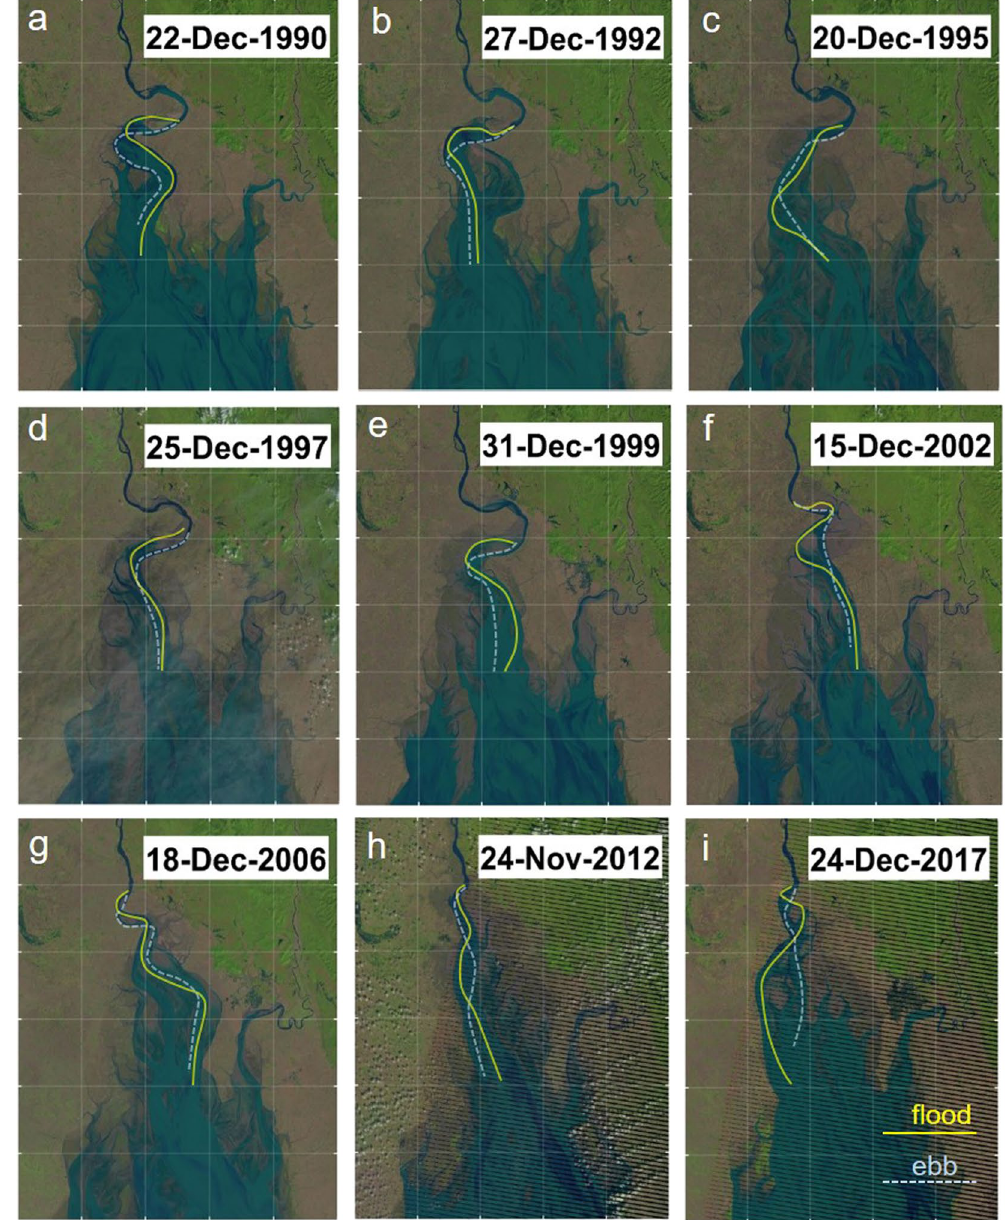
Figure 4. Cyclic Channel migration from 1990 to 2017. Cyclic channel migration is illustrated by sequential Landsat images at every quarter phase of the cycle. Yellow and light-blue lines highlight dominant flood and ebb flow courses in main channel, respectively. Sinuous channel migrated laterally with its end fixed in upper channel. Channel migration caused erosion on two sides of central basin alternately. Landsat imagery courtesy of NASA Goddard Space Flight Center and U.S. Geological Survey. Figure was created using MATAB ver. R2006b from Mathworks Inc. Figure labels were added using Microsoft Powerpoint